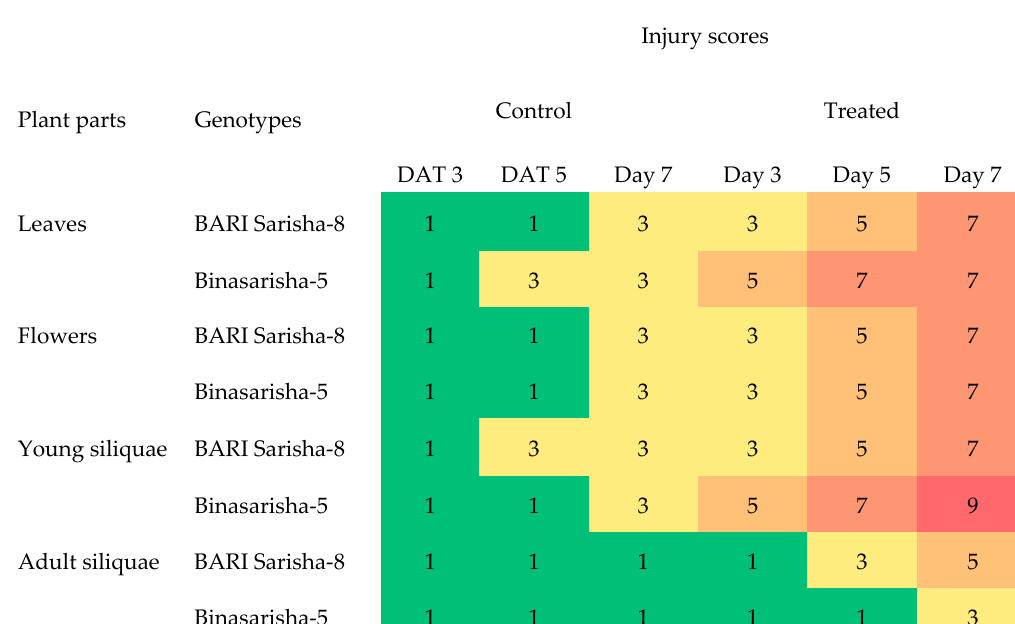
Figure 4. Effect of salinity on the reproductive organs at 7 d after treatment. ( a ) Inflorescence under control conditions; ( b ) inflorescence under 100 mM NaCl; ( c ) siliquae at control conditions; and ( d ) siliquae under 100 mM NaCl.